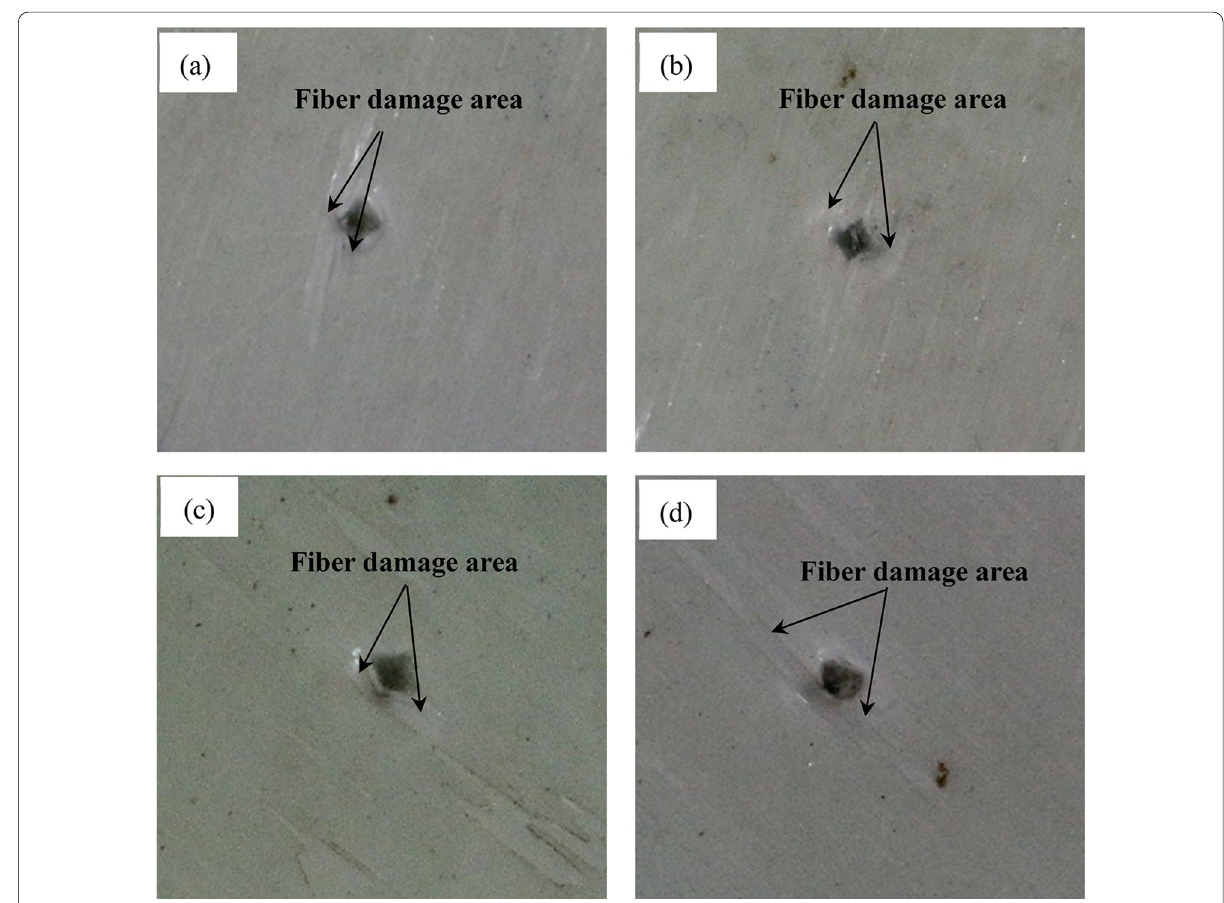
Fig. 13 When the drop-weight is 2 kg and the drop-height is 1 m, the impact failure state of four bionic specimens. a 15°, b 30°, c 60°, d